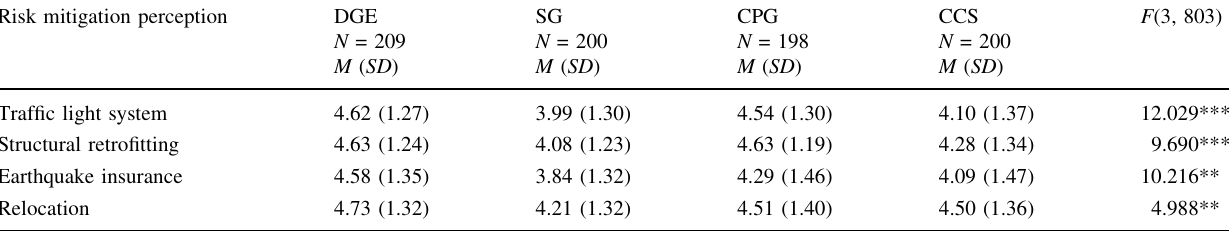
Relocation Values range from 1 = low to 7 = high